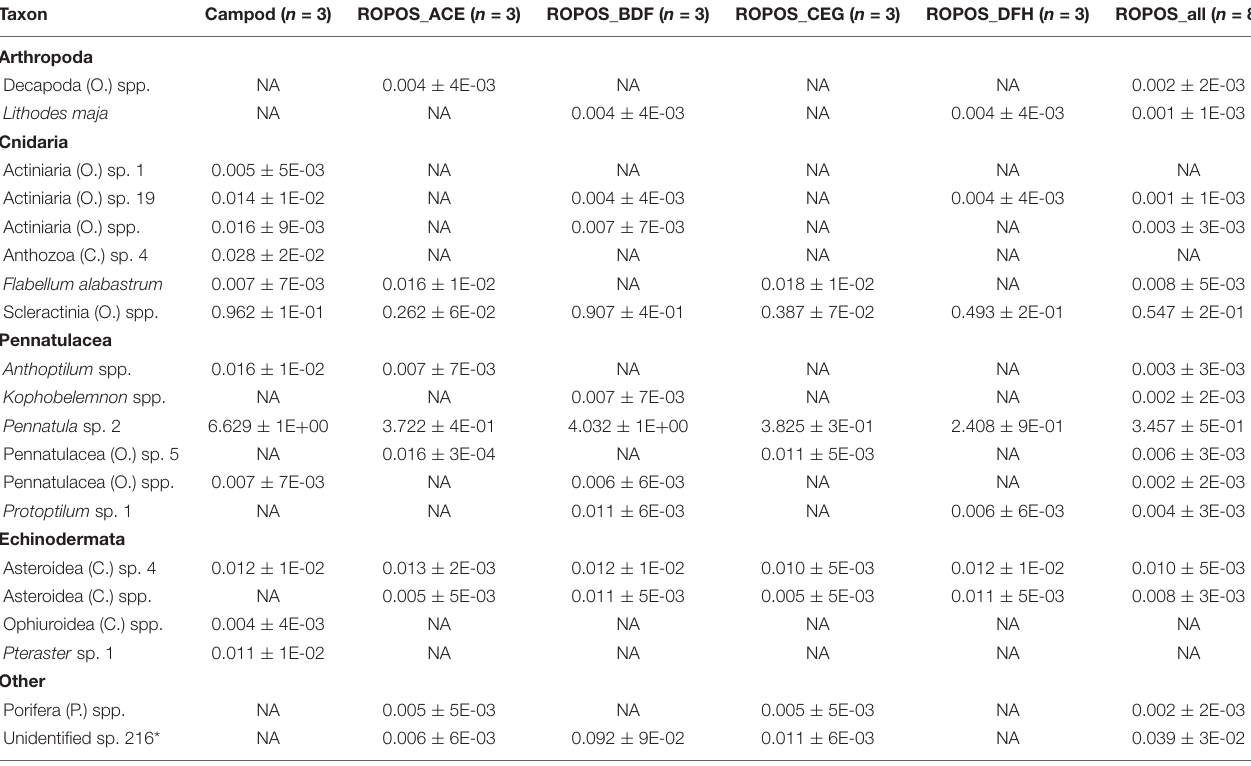
TABLE 3 | Abundance of individuals or colonies m − 2 (mean ± SE) at station LC2 in the Laurentian Channel MPA averaged across transect and then averaged across each of six sampling designs. Taxon Campod ( n =